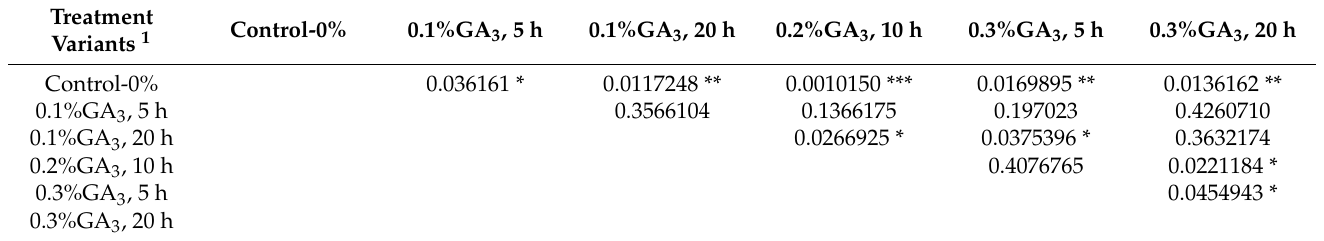
Table 3. Differences between the groups of treatment variants with the same light and different levels of GA 3 pretreatment for seedlings with cotyledons/first true leaves of P. veris (Excel t -test paired